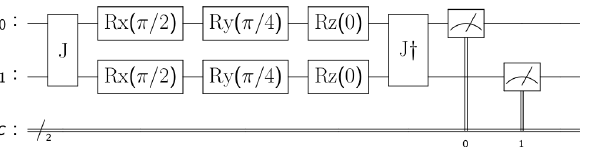
Figure 5. Game model for 2